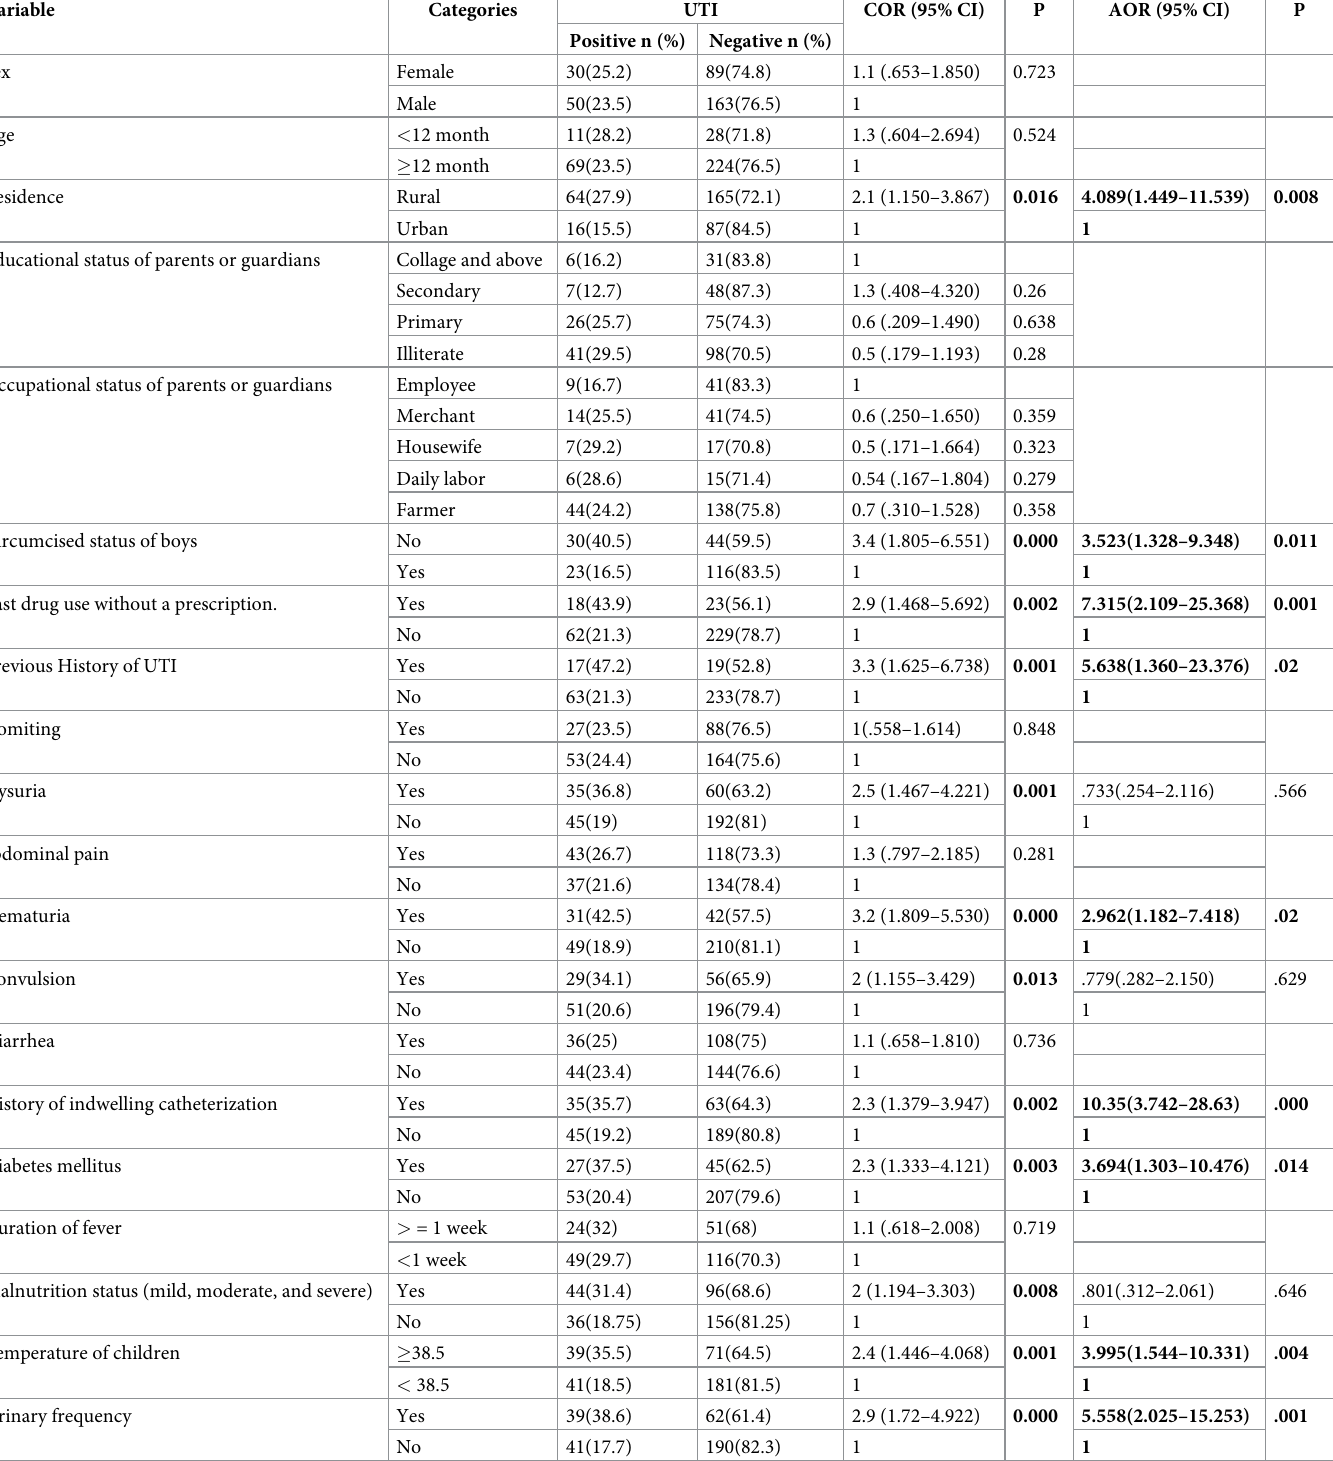
Table 3. Factors associated with UTIs among under-five children at HFSUH, eastern Ethiopia,